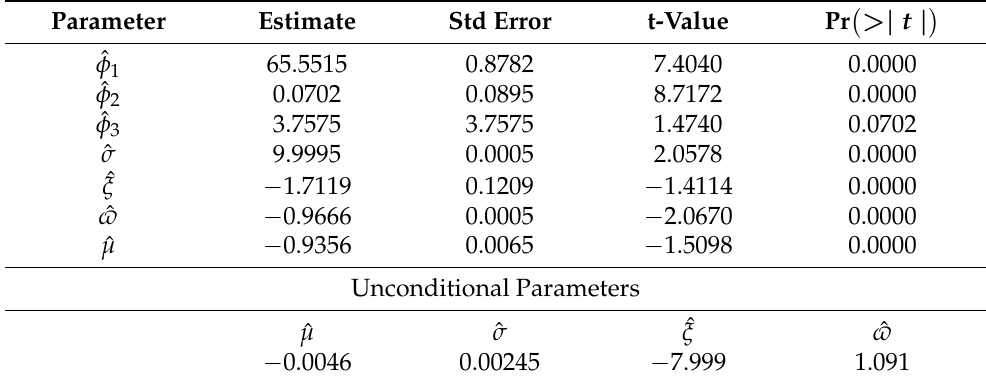
Figure 2. Traces of three GEVD for parameters ξ , µ , and σ showing the maximum iterations used to estimate these parameters. Table 3. Bayesian parameter estimates of the proposed GAS–GEVD. The estimates are from the i.i.d residuals of the SARIMA model. The GAS–GEVD is fitted using a block minima (BM) with the block size of